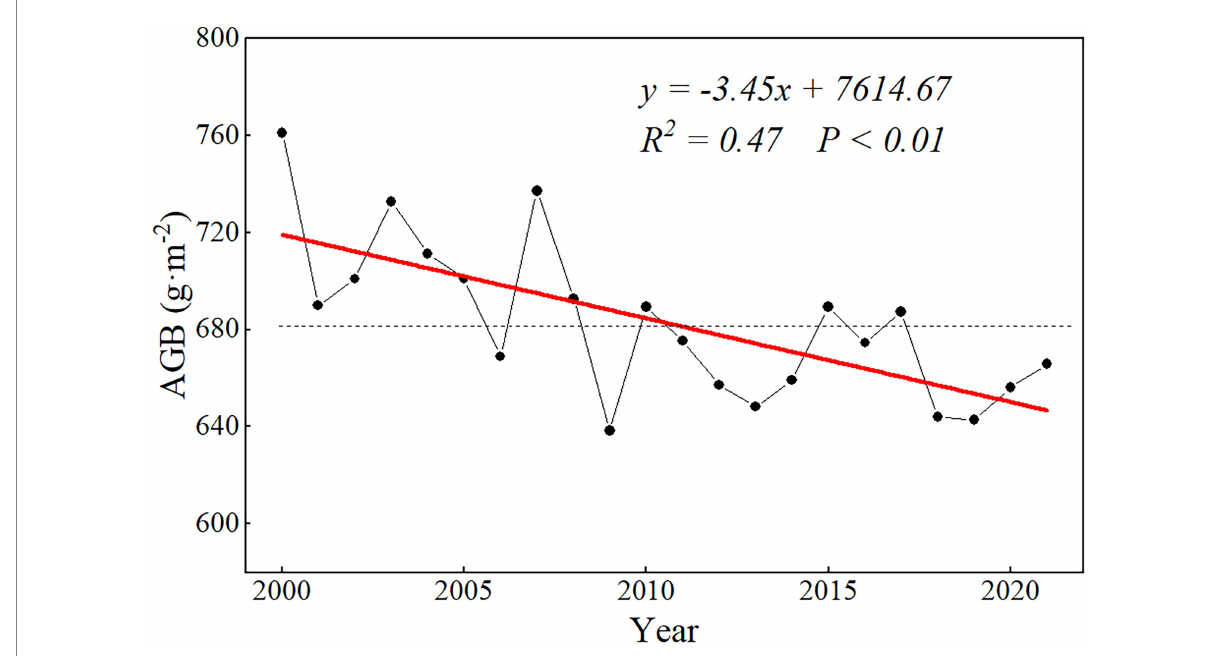
FIGURE 3 Temporal variation of marsh AGB in Northeast China from 2000 to 2021.